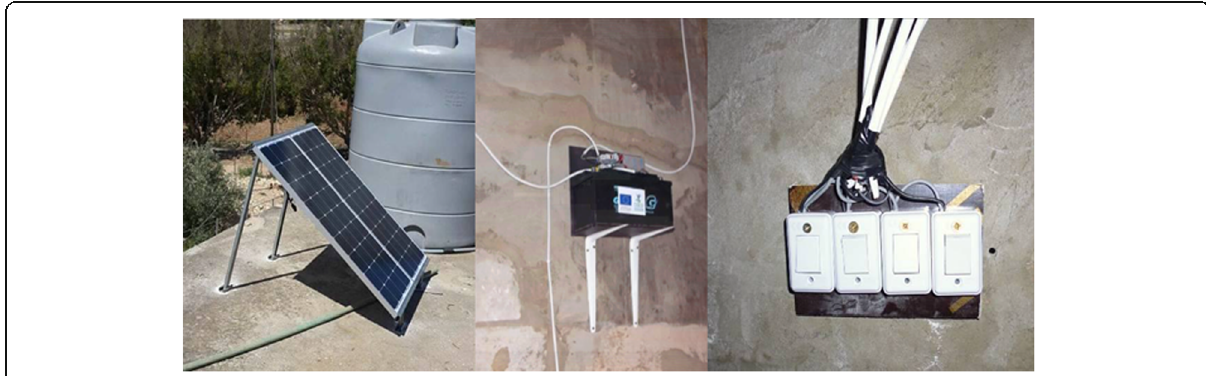
Fig. 4 Main components of the standalone PV